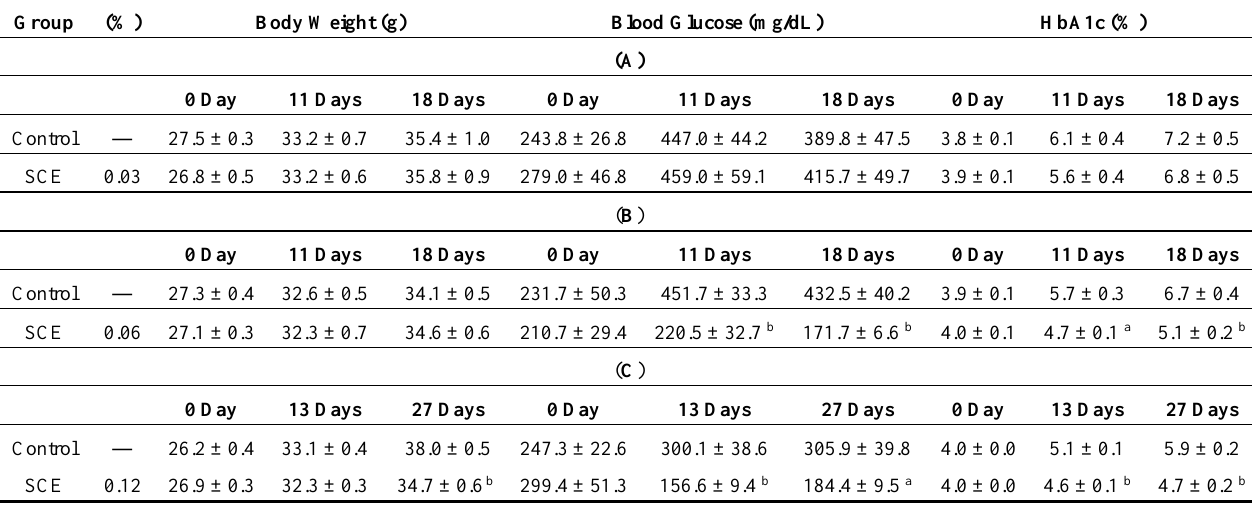
Table 5. Effects of chronic administration of SCE on HbA1c levels in AIN93M purified diet-fed KK-A y